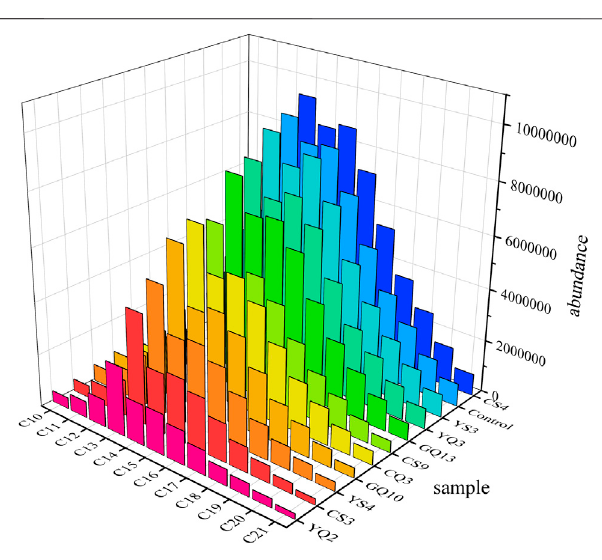
FIGURE 8 | GC-MS of residual diesel. (Peak heights of n-alkanes C 10 - C 21 in GC-MS